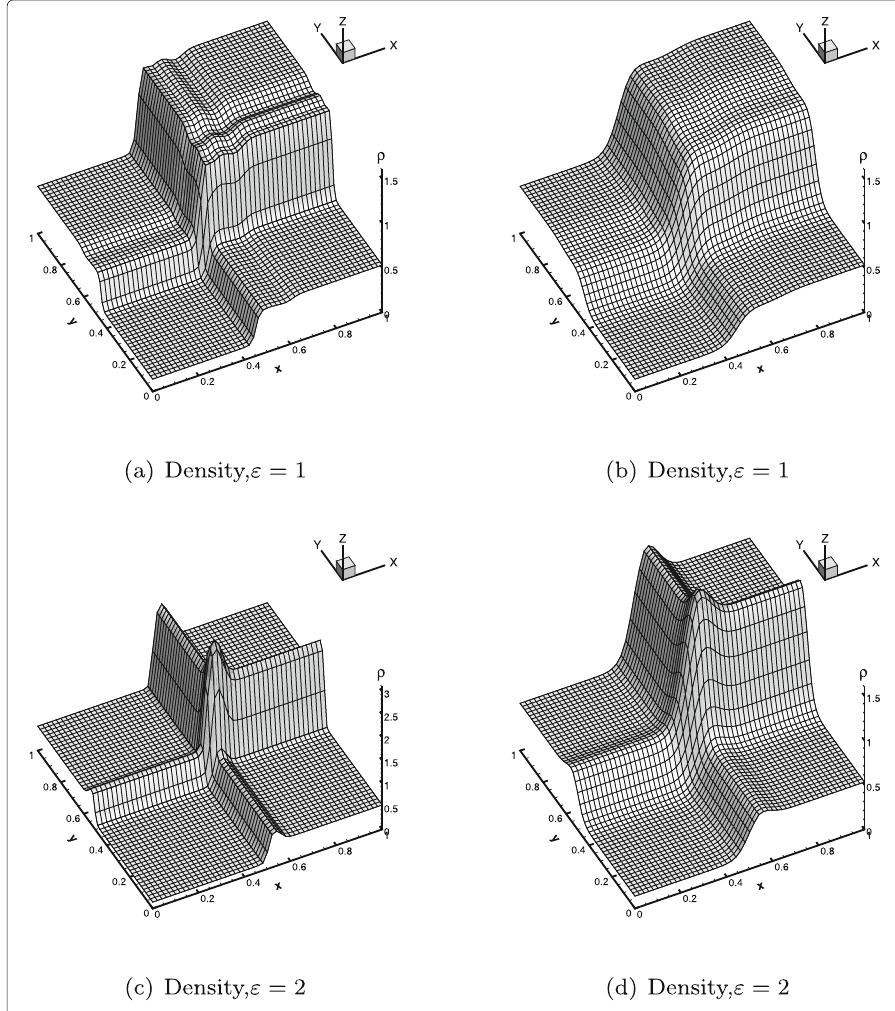
Fig. 3 Example 5. Density obtained with the GSA IMEX-ARS3 WCNS (left) and the GSA IMEX-ARS3 MUSCL (right) on a mesh 50 × 50 at t = 0.1. The values of the Mach number are ε = 1 (top) and 2 (bottom). a Density, ε = 1. b Density, ε = 1. c Density, ε = 2. d Density, ε = 2